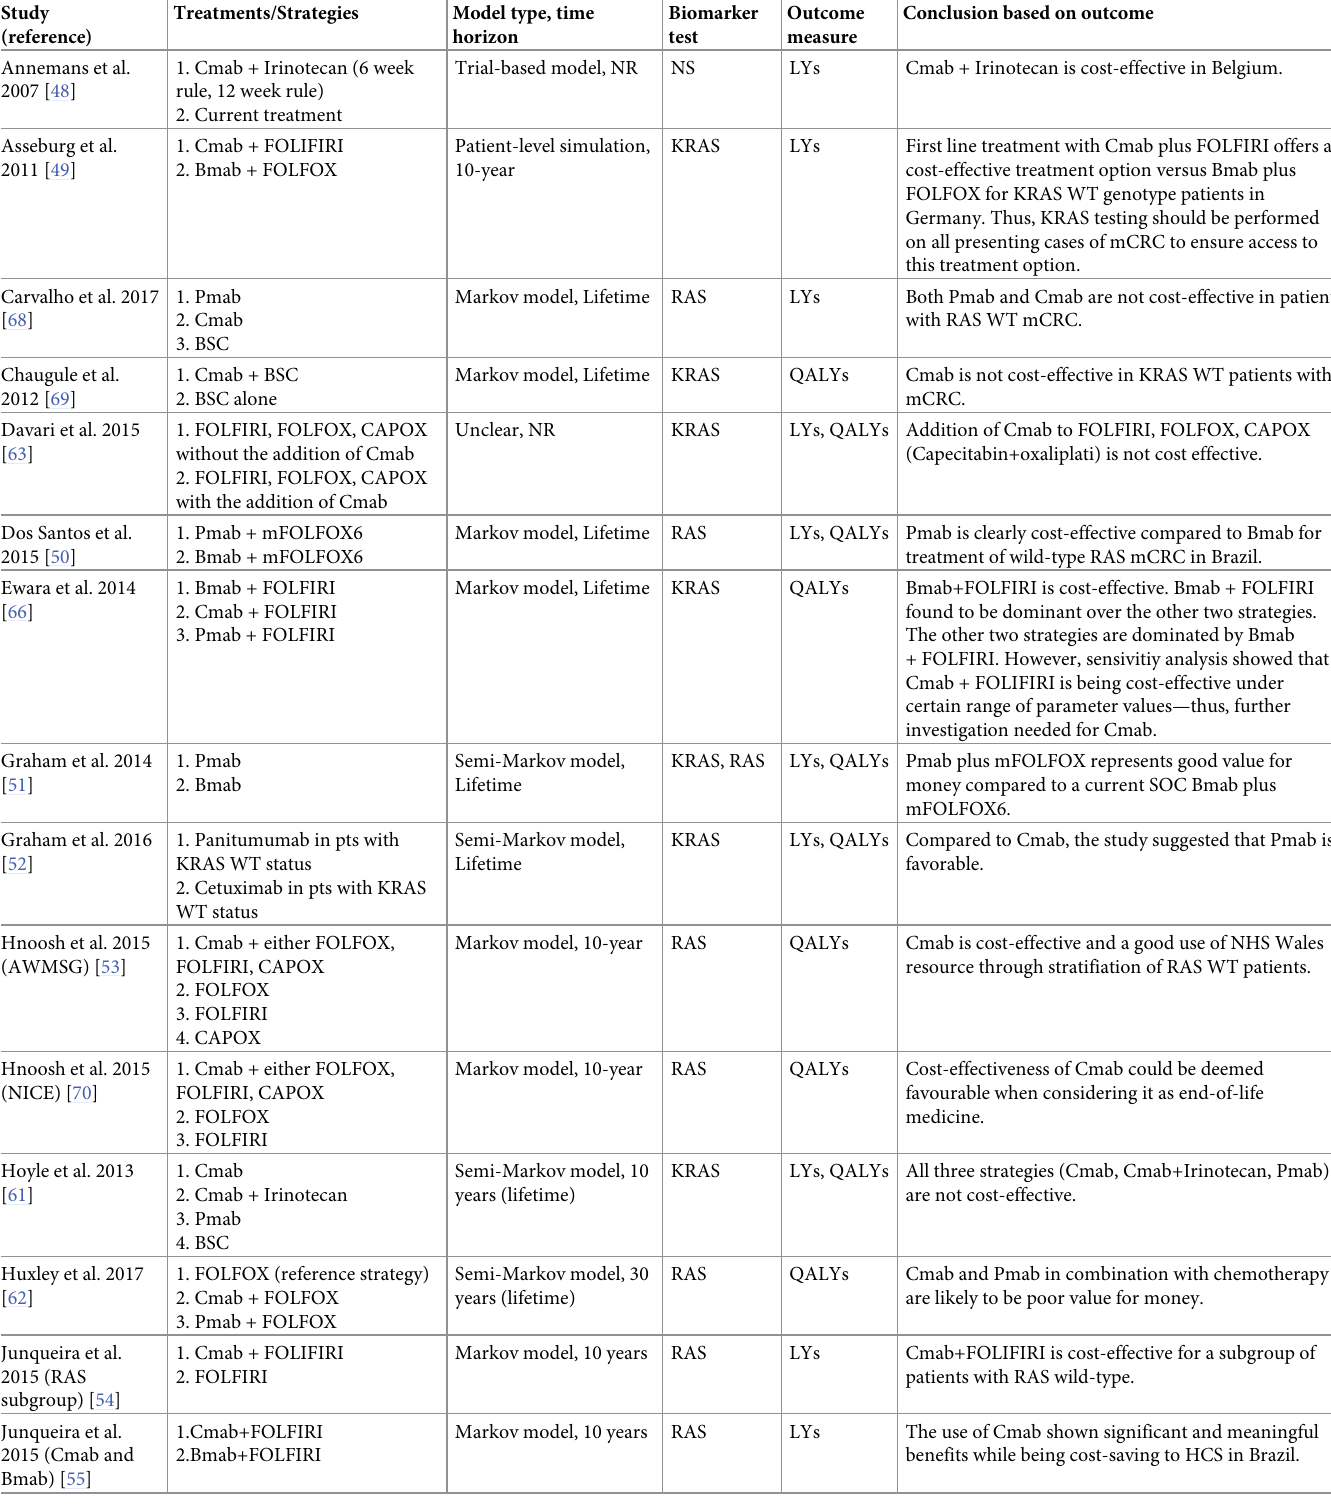
Table 4. Cost-effectiveness of targeted therapies licensed with companion